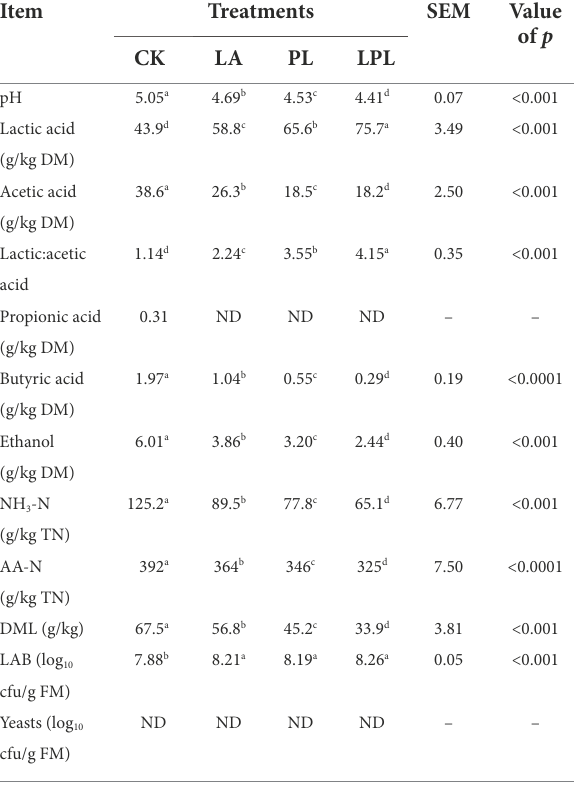
TABLE 2 Fermentation characteristics and losses of alfalfa silage treated without or with different additives.